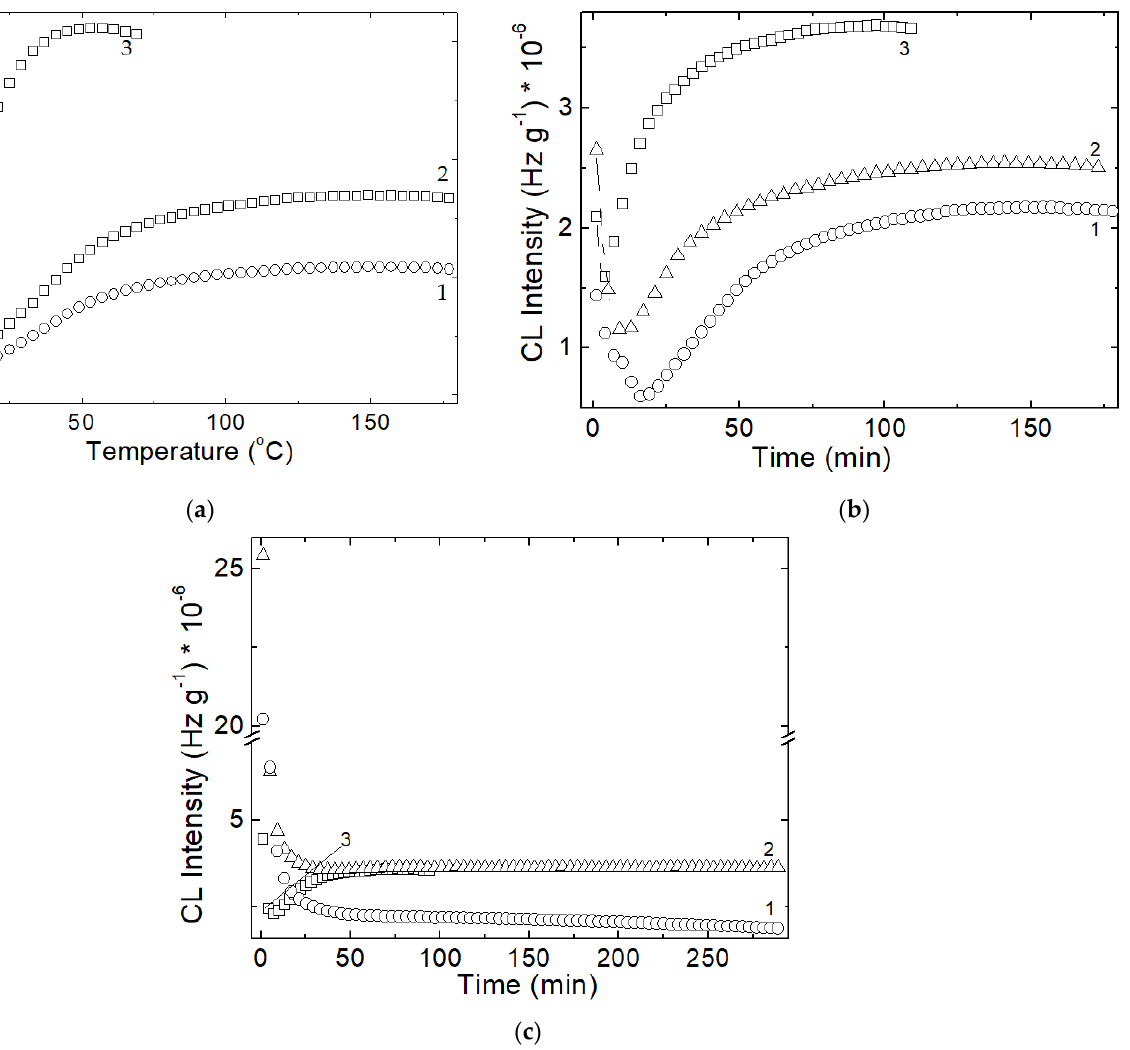
Figure 7. Isothermal CL spectra recorded on PCL:SIS samples after their irradiation at 100 kGy. Temperatures: (1) 130 °C; (2) 140 °C; (3) 150 °C; ( a ) PCL:SIS = 3:1; ( b ) PCL:SIS = 1:1; ( c ) PCL:SIS = 1:3.